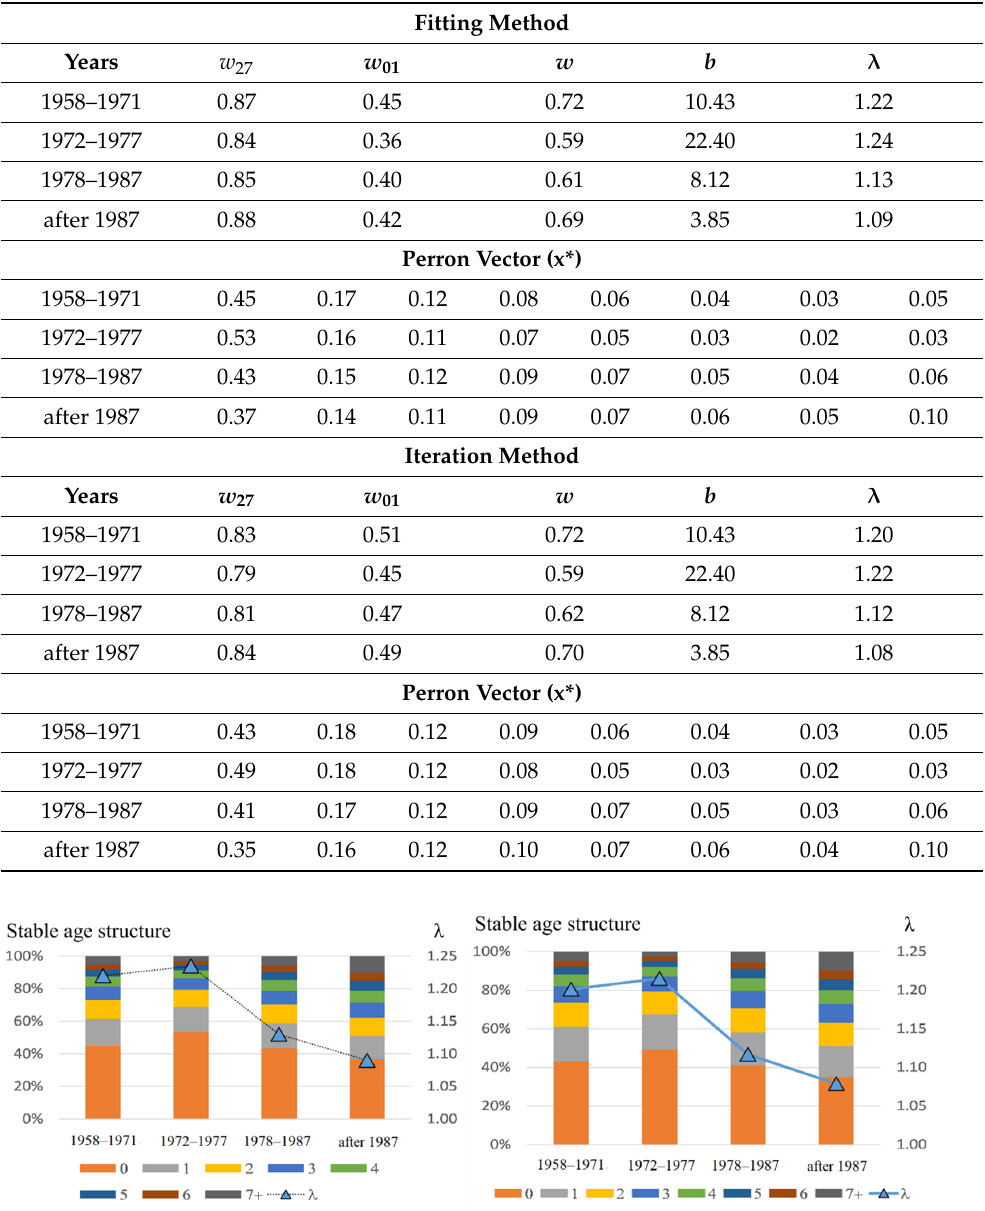
Table 1. Model coefficient values (adapted from [25]), annual growth rate of the population ( λ ) and its stable age structure (x*).